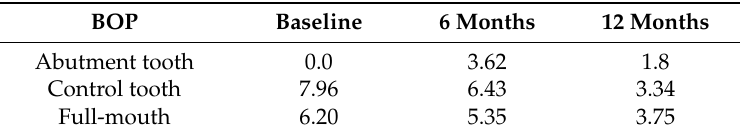
Table 3. BOP at baseline, 6 months, and 12 months follow-up.